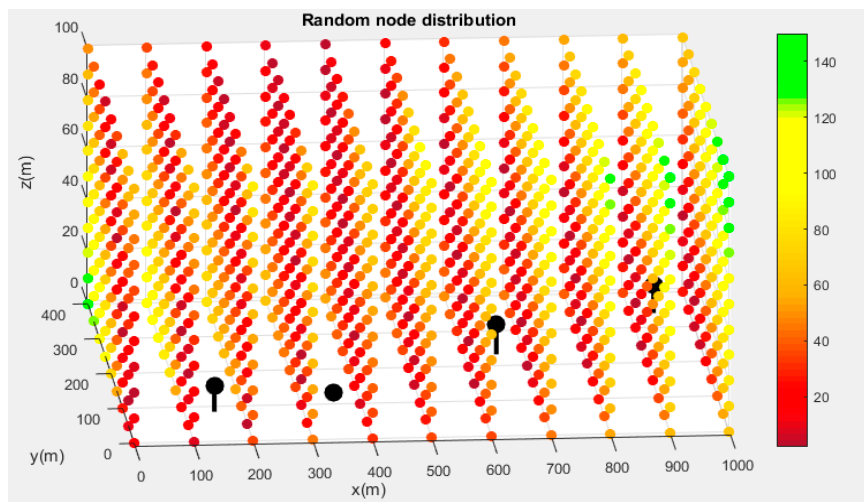
Sensors 2019 , 19 , x FOR PEER REVIEW Figure 6. Evaluation of the convergence radius in the coverage area for a random distribution.